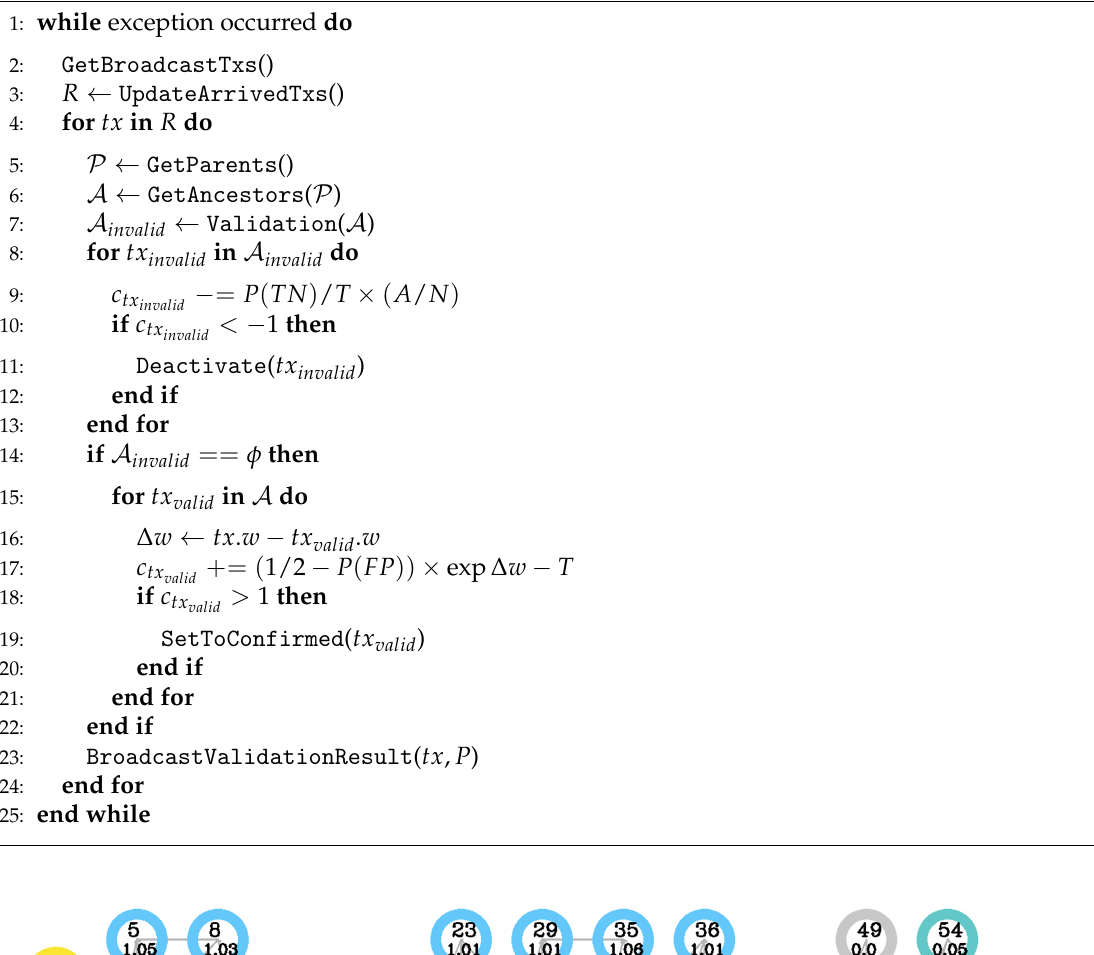
Algorithm 1 PowerGraph consensus algorithm.